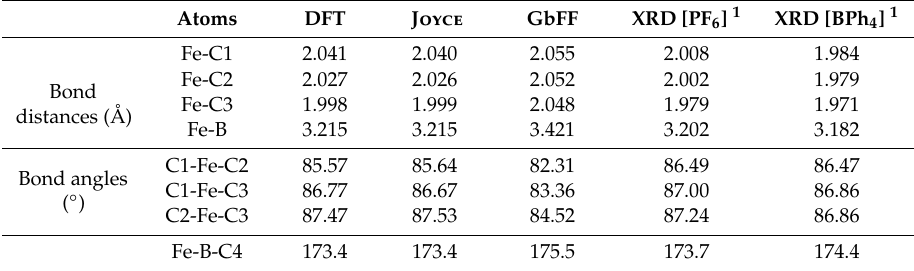
Table 1. Main geometrical parameters (bond distances and angles) defining the octahedral coordination of the complex, as obtained from the QM (DFT), MM (J oyce and GbFF) relaxed structures and from XRD measurements performed in [PF 6 ] and [BPh 4 ] counterion single-crystals, as reported in ref. [37]. The adopted atom labeling is depicted in Figure 2a. The level of theory adopted for the DFT calculations was B3LYP* / 6-311G* (see Section